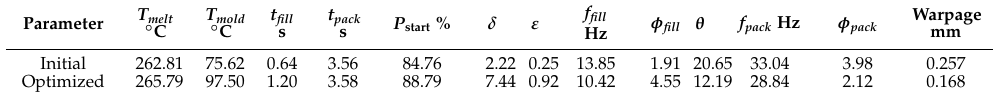
Table 11. Dynamic parameters and warpage results of the PC light cover.